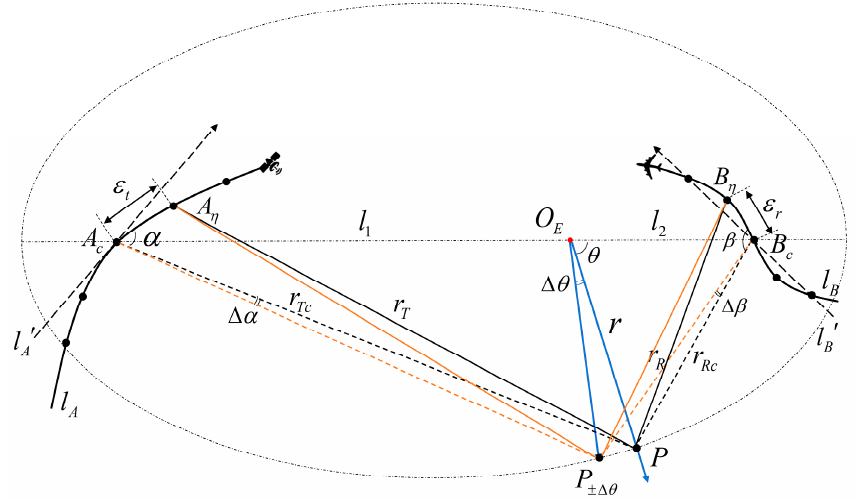
Figure 4. Angular dimension sampling requirement of the subimages in the OEP system. In Figure 4, 𝑙 (cid:3002)(cid:4593) and 𝑙 (cid:3003)(cid:4593) are the normal linear trajectories of the GEO satellite and air- craft, respectively, while 𝑙 (cid:3002) and 𝑙 (cid:3003) are their actual trajectories. 𝐴 (cid:3030) and 𝐵 (cid:3030) are the cen- ters of the 𝑙 th subapertures, respectively, while 𝐴 (cid:3086) and 𝐵 (cid:3086) are the positions of the satel- lite and aircraft at the slow time 𝜂 , respectively. 𝑃 and 𝑃 ±(cid:3057)(cid:3087) are two consecutive sam- pling points in the imaging scene with the same two-way slant range with the coordinates (𝜌, 𝜃) and (𝜌, 𝜃 ± 𝛥𝜃) , respectively. 𝑟 𝑟 𝐴 𝐴 (cid:3021)(cid:3030) and (cid:3021) denote the distance from (cid:3030) and (cid:3086) to the target 𝑃 , respectively, the straight-line distance from 𝐴 (cid:3030) to 𝐴 (cid:3086) is denoted by 𝜖 (cid:3047) , and the angle between the lines 𝐴 (cid:3030) 𝐴 (cid:3086) and 𝑟 (cid:3021)(cid:3030) is denoted by 𝛼 . Similarly, 𝑟 (cid:3019)(cid:3030) and 𝑟 (cid:3019) denote the distance from 𝐵 (cid:3030) and 𝐵 (cid:3086) to the target 𝑃 , respectively, the straight-line distance from